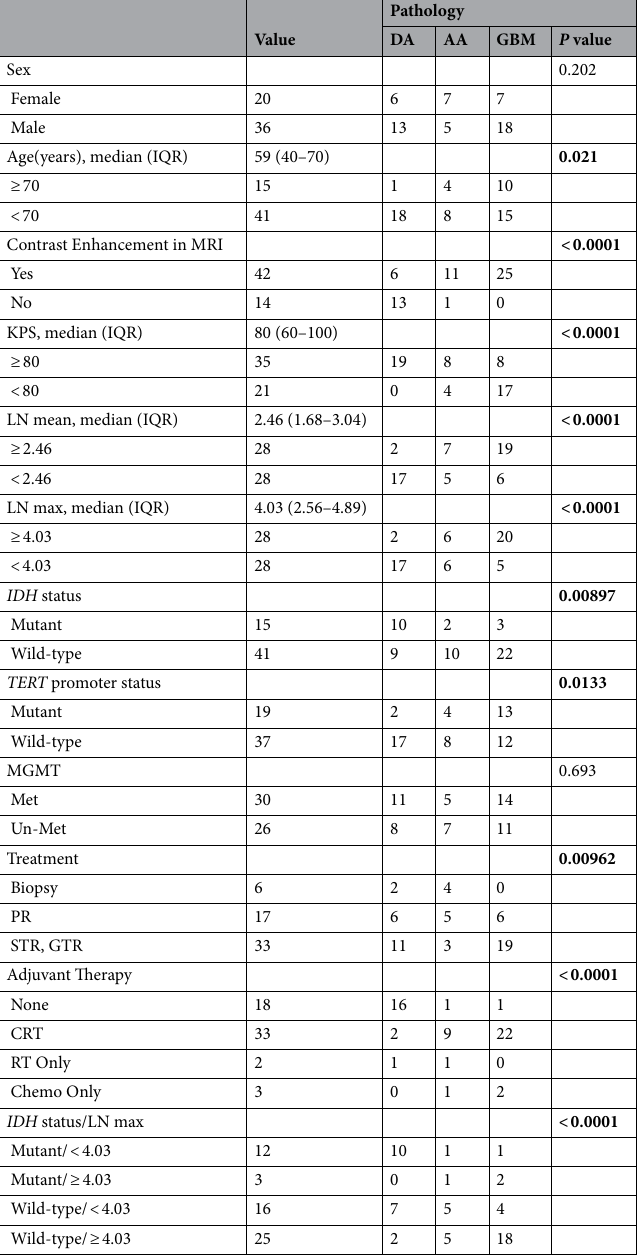
Table 1. Patient characteristics and histology based on the revised WHO 2016 classification IQR interquartile range, MRI magnetic resonance imaging, KPS Karnofsky performance status, LN lesion-to-contralateral normal brain tissue, IDH isocitrate dehydrogenase, TERT telomerase reverse transcriptase, MGMT O 6 - methylguanine-DNA-methyltransferase, CRT chemoradiotherapy, RT radiation therapy, Chemo chemotherapy, PR partial resection, STR subtotal resection, GTR gross total resection, DA diffuse astrocytoma, AA anaplastic astrocytoma, GBM glioblastoma. P values in bold font are statistically